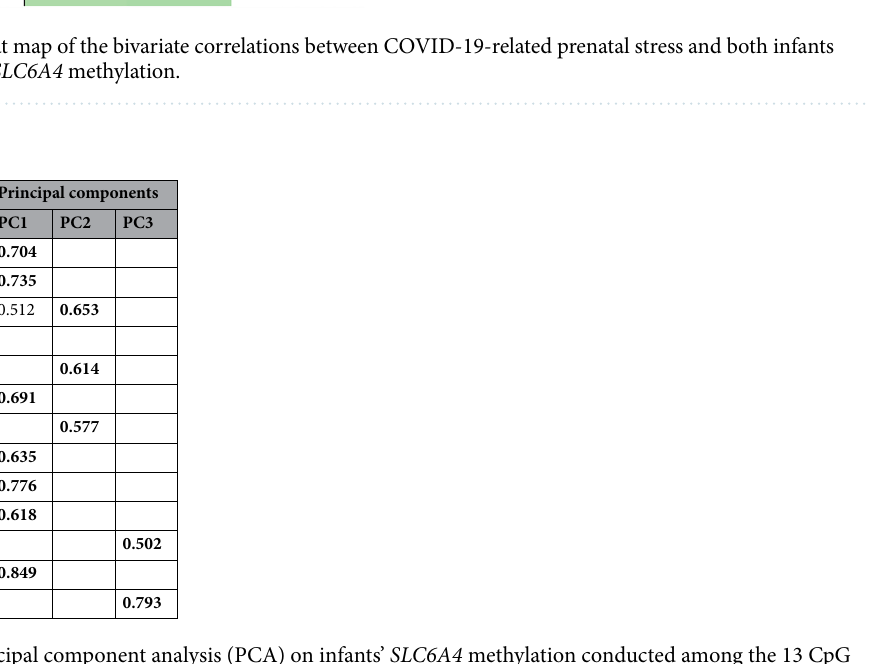
Table 2. Principal component analysis (PCA) on infants’ SLC6A4 methylation conducted among the 13 CpG sites. Loadings on the respective principal components (PC) are reported in bold. Loadings < 0.500 are not